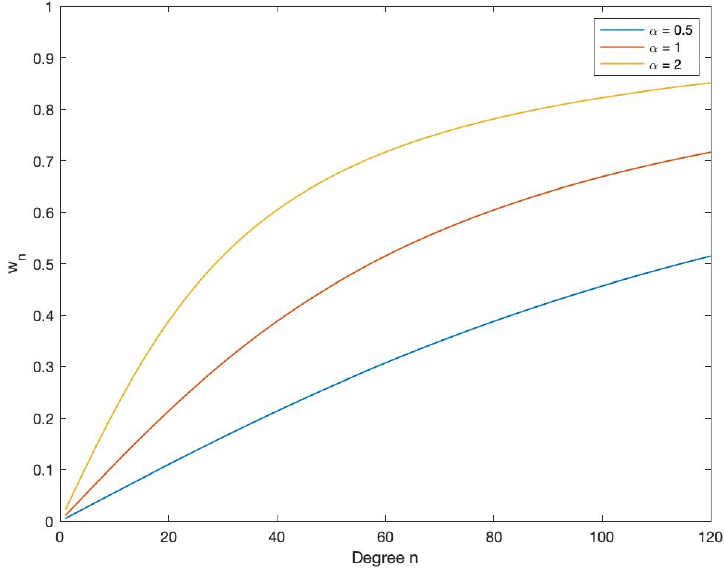
Figure 7. Degree-dependent weight w n for selected values of α .